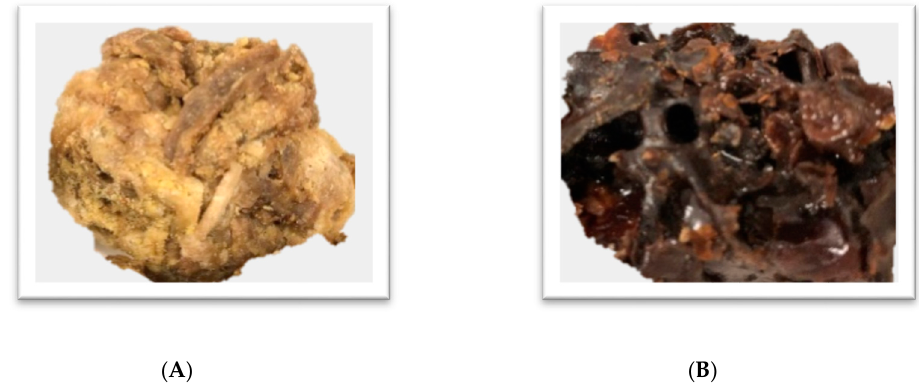
Figure 2. Propolis of the honey bee A. mellifera ( A ) and the Australian stingless bee Tetragonula carbonaria ( B ).